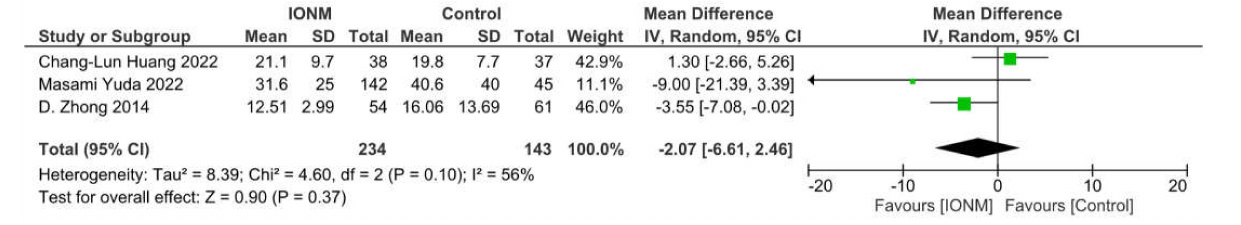
Figure 9. Forest plot of IONM for POHS. Abbreviations: IONM—intraoperative neuromonitoring, POHS—postoperative hospital stay.